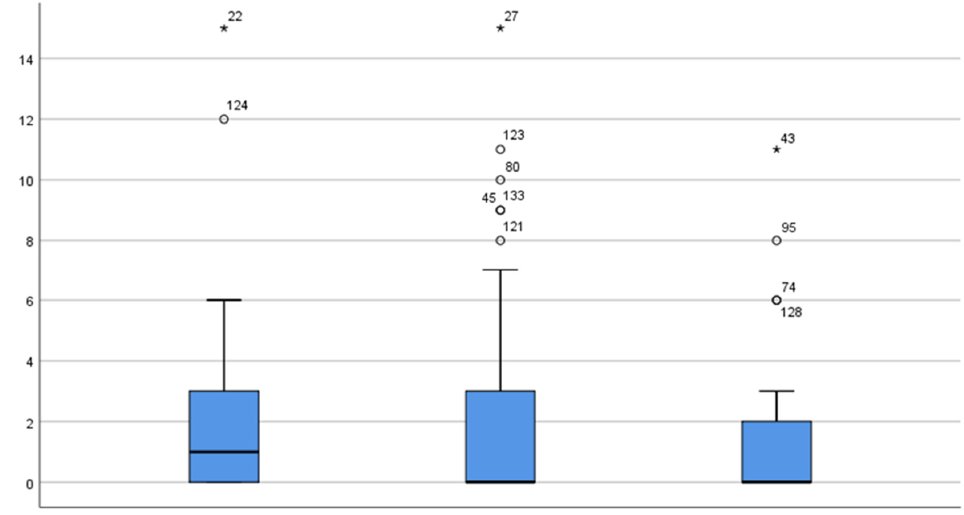
Figure 1. Stem and leaf analysis of the chronotypes * and the oppositional behaviours. Morning, intermediate and evening types (in the order of left to right in the figure) are distributed in the Y axis according to the oppositional behaviours values in the X axis (punctuations are from the scale of the oppositional behaviour).